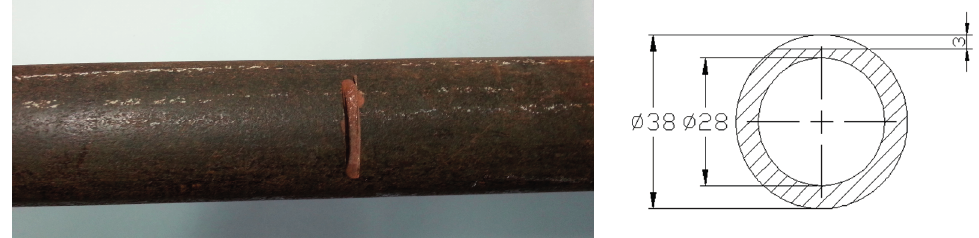
Figure 4. The photo and the schematic diagram of the